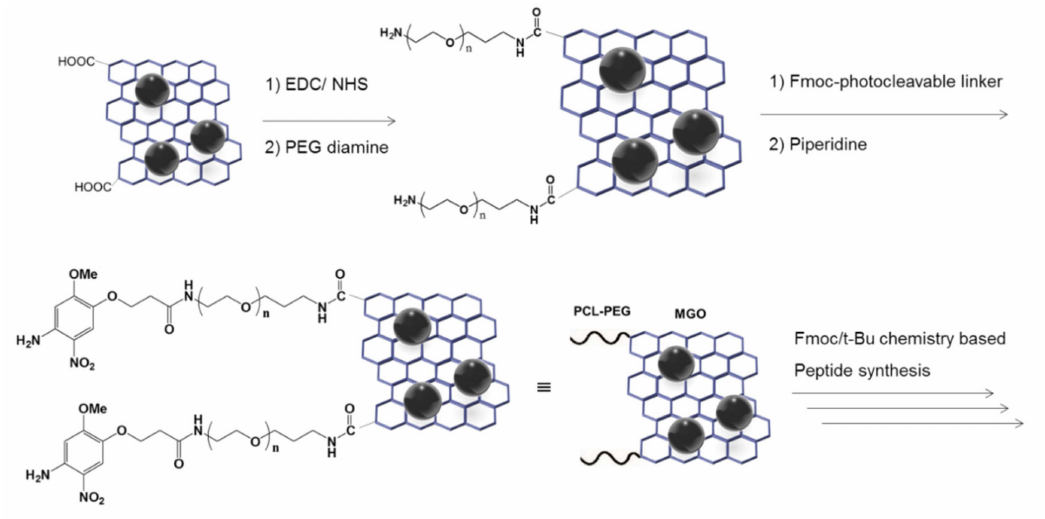
Figure 2. Coupling of polyethylene glycol (PEG) diamine and photocleavable linker (PCL) to MGO. After peptides were synthesized on the MGO matrices, the peptides were released by the cleavage of PCL upon UV irradiation (365 nm). Peptide sequences were confirmed by matrix assisted laser desorption / ionization time-of-flight mass spectrometry (MALDI-TOF MS) analysis after magnetic separation (Figure 3). Two strong peaks in the MALDI-TOF spectra at 628.37 and 659.33 shown in + Figure 3B,C corresponded to the theoretical mass-to-charge ( m / z , [M + H] ) values of H-LVPRGS-NH 2 and H-EVNLDA-NH 2 peptides, respectively. This result demonstrates that the MGO nano-composite materials with capability of direct peptide synthesis can be a potential platform for the FRET-based protease